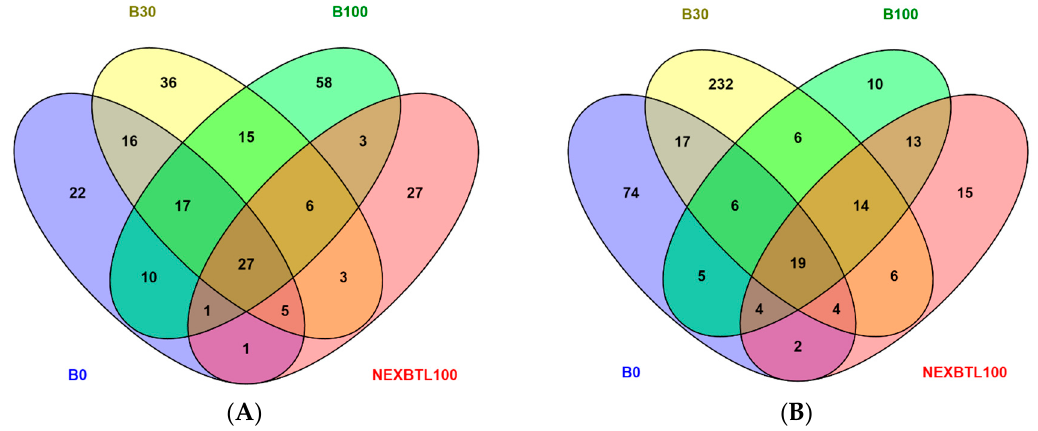
Figure 5. Venn diagrams illustrating the overlap of genes commonly modulated in response to all DEP extract treatments as well as numbers of specifically modulated genes by each individual DEP extract upon: ( A ) 4 h; and ( B ) 24 h incubation.